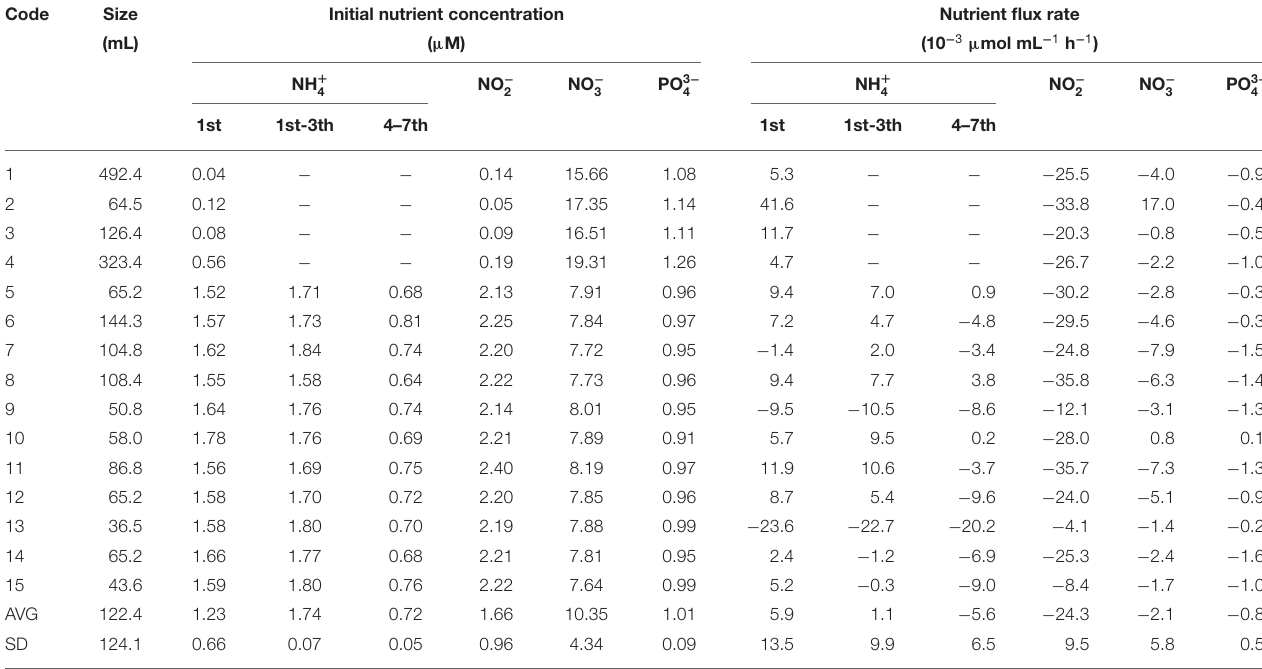
TABLE 2 | Summary of nutrient fluxes and associated parameters in the incubations of Vazella pourtalesii . Code